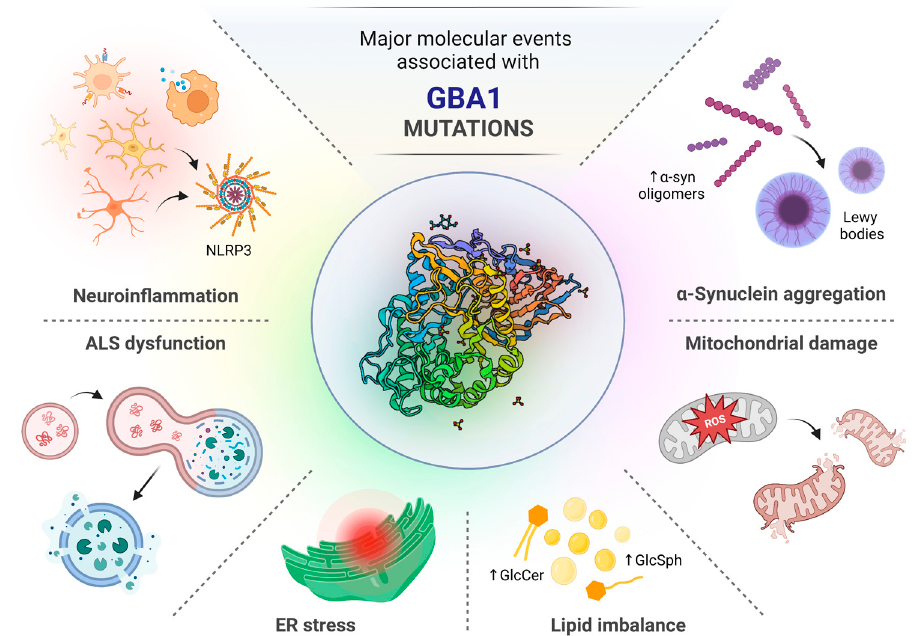
Figure 2. The schematic representation of major molecular consequences induced by GBA1 mutations. The structure of the GBA1 protein is presented in the middle (PDB ID: 1OGS). Mutations in GCase usually result in significant decrease in enzyme activity, that in turn greatly impacts the functionality of autophagy–lysosomal system (ALS); this affects lipid homeostasis due to accumulation of glucosylceramide (GlcCer) and glucosylsphingosine (GlcSph) as well as facilitates aggregation of α -synuclein ( α -syn). Excessive accumulation of lipids and abnormal proteins within the cell induces endoplasmic reticulum (ER) stress conditions and cause damage to the mitochondria. All mentioned events lead to induction of neuroinflammatory response with subsequent activation of NLRP3 inflammasome.